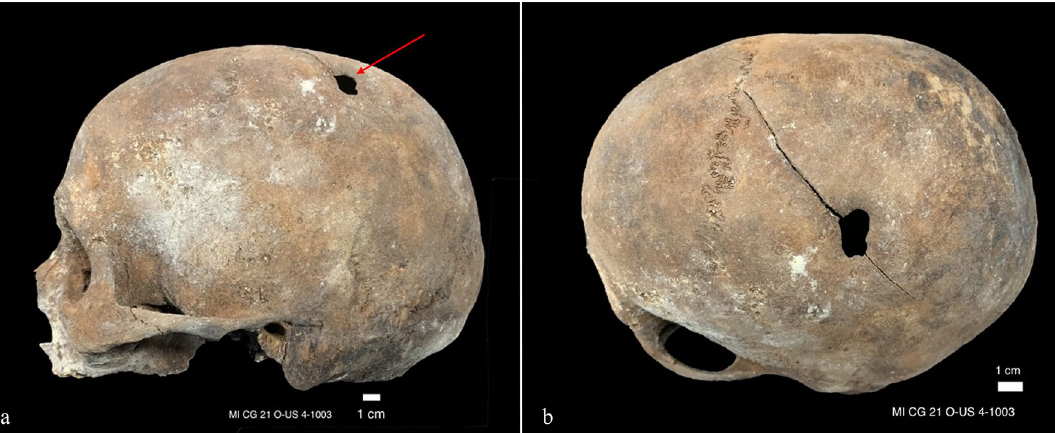
Figure 2. ( a ) Left lateral view of cranium MI CG 21 O-US 4-1003. Ante-mortem trauma of the left parietal bone (arrow), followed probably by trepanation and long term healing; ( b ) superior-lateral view of ante-mortem trauma on cranium MI CG 21 O-US